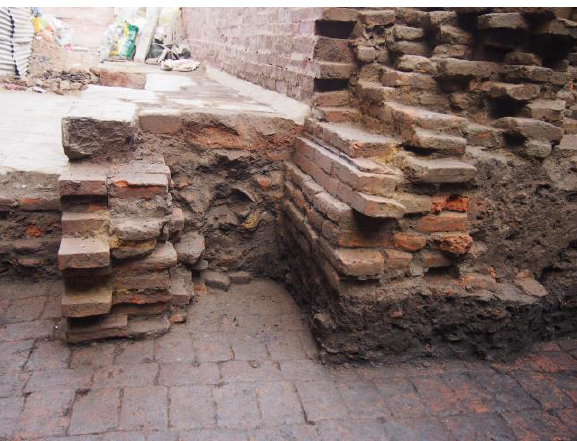
Figure 14. Excavated section at Jaisi Dega showing stacked bricks in the upper right with mud mortared bricks on the vertical faces of the